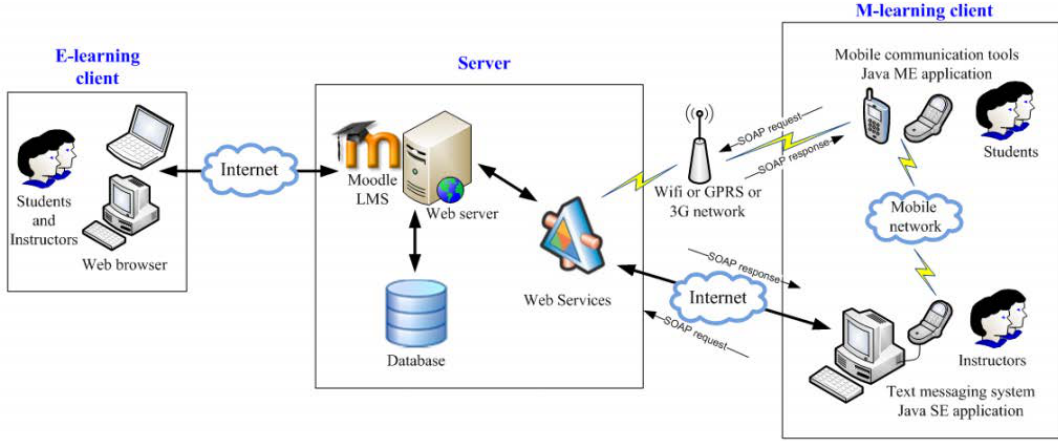
Figure 2. Architectural diagram of the integration of the Moodle LMS with the mobile communication tools.